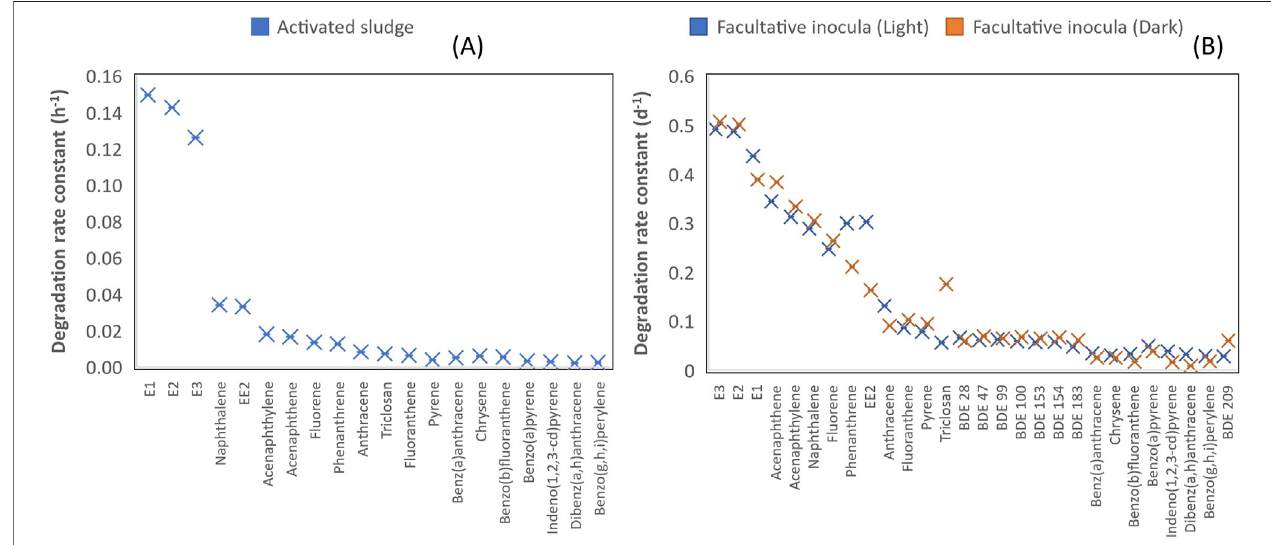
FIGURE3|(A) Degradationrateconstantofdifferentclassesofchemicalsunderaerobicconditionswithactivatedsludgeinocula. (B) Degradationrateconstantof different classes of chemicals under aerobic condition with facultative inocula (light and dark incubation conditions).